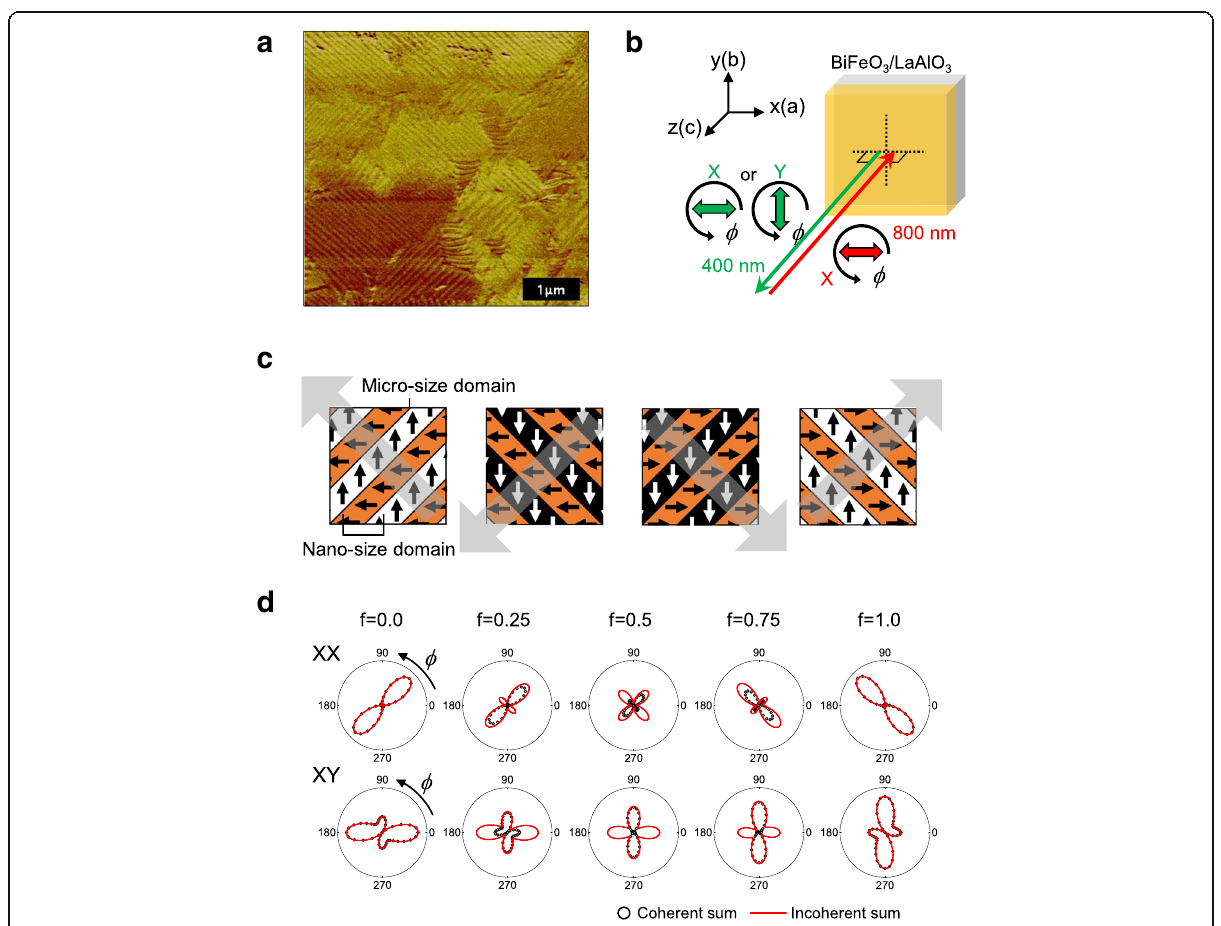
Fig. 1 Ferroelectric domain distribution in a tetragonal BiFeO 3 film and expected second harmonic generation results as coherent and incoherent contributions of multi-domains. a Piezoelectric force microscope image. Stripe-patterned domains are seen with two distinct orientations. b Schematic description of the second harmonic generation experiment. c Four types of stripe patterns of ferroelectric domains. d Polar plots of simulated second harmonic responses depending on a portion of different domains. Both coherent and incoherent summations are